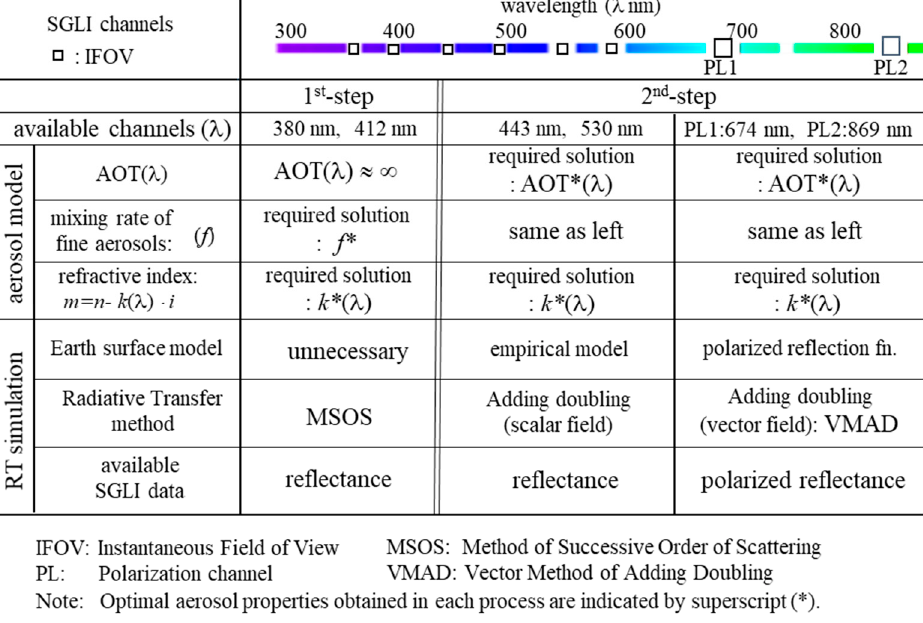
Figure 1. Process chart of radiation simulation for aerosol retrieval in the case of sever wildfires GCOM-C/SGLI using GCOM-C/SGLI data.